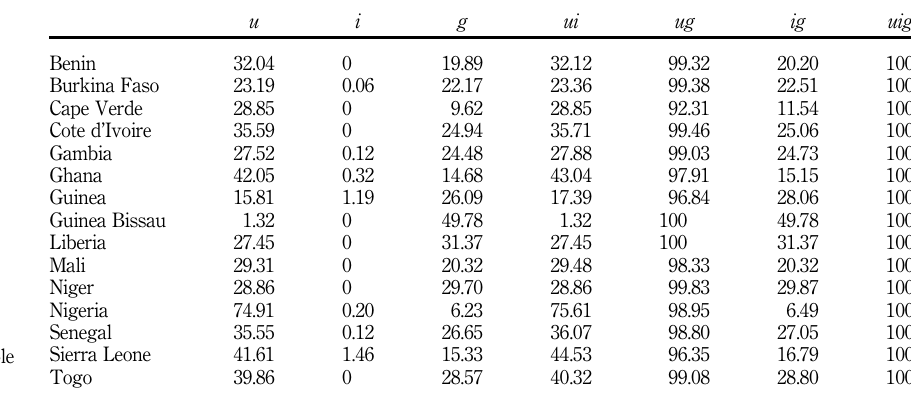
functions of the West African Triple Helix